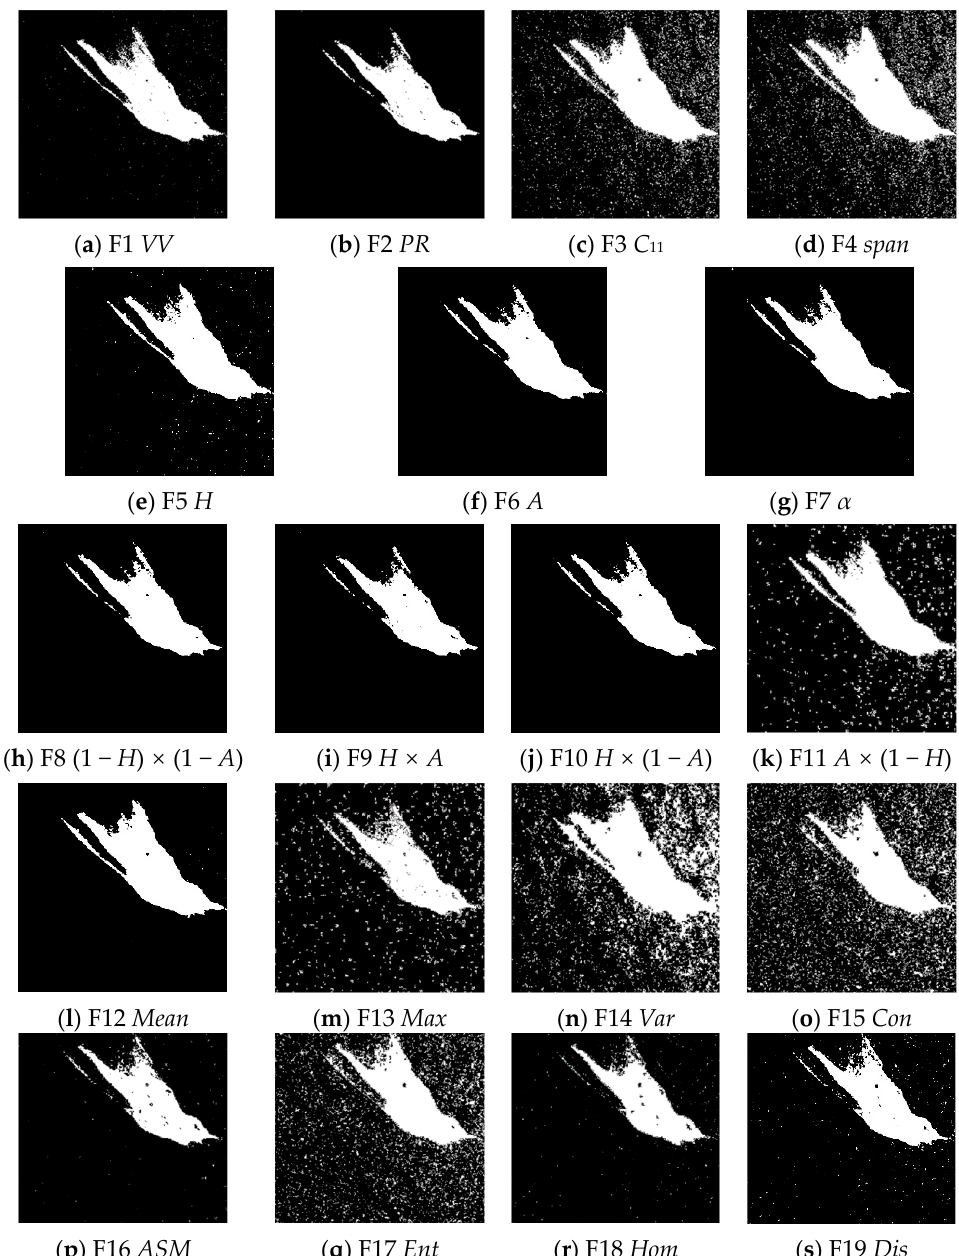
Figure 10. Image segmentation result for data a based on K-means algorithm.